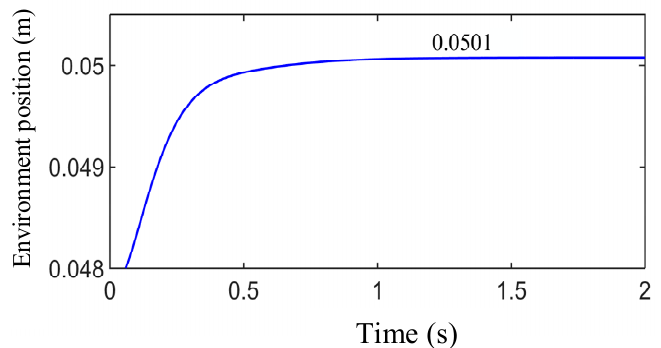
Figure 16. Simulation diagram of environmental location estimation.